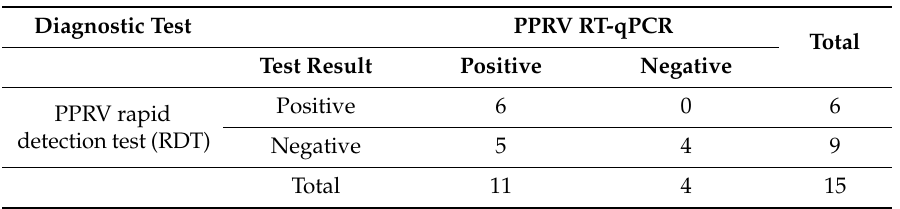
Table 3. Comparison of peste des petits ruminants virus (PPRV) rapid detection test (RDT) and